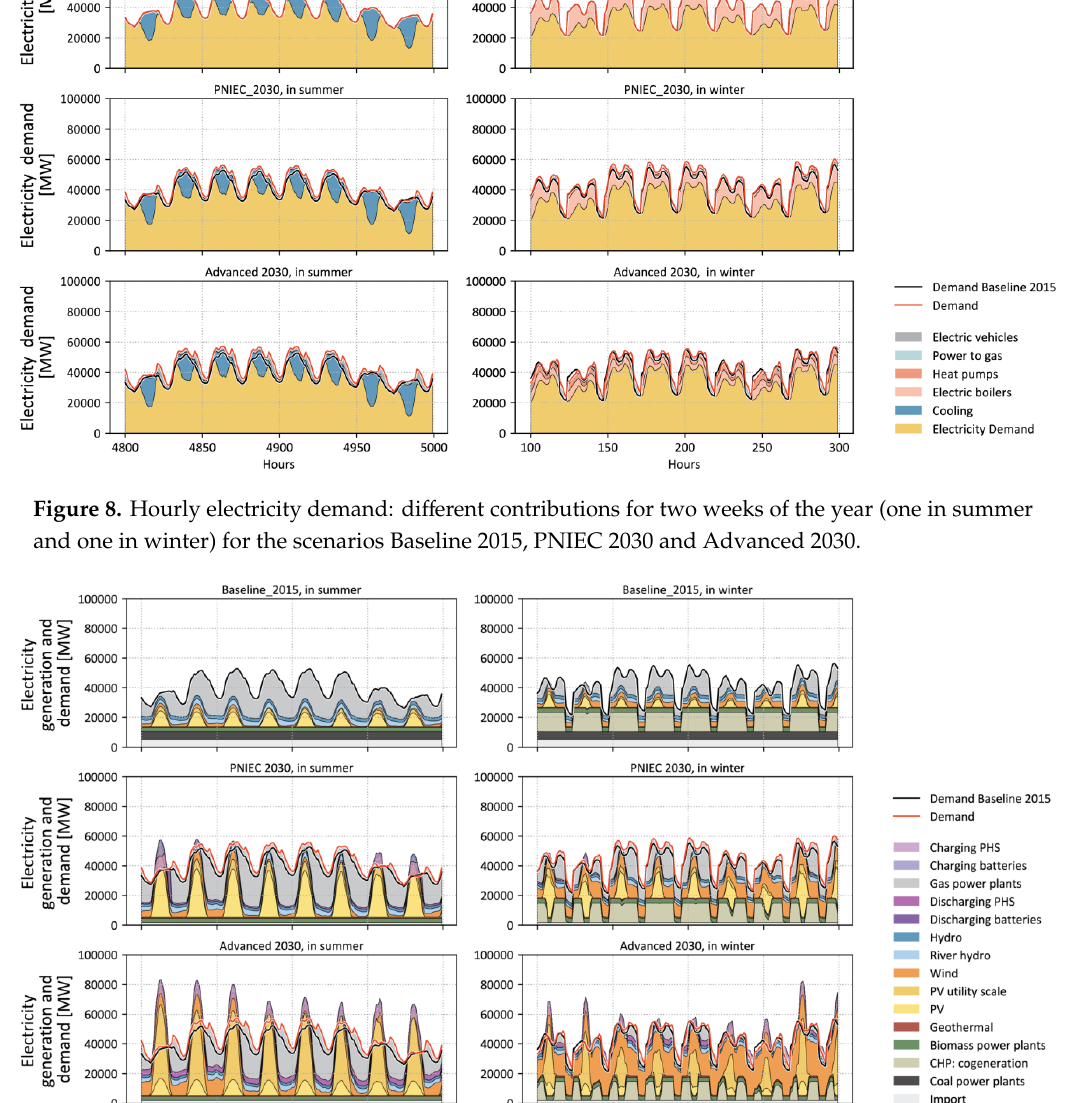
Figure 10. Annual electricity generation for the scenarios Baseline 2015, PNIEC 2030 and Advanced 2030.